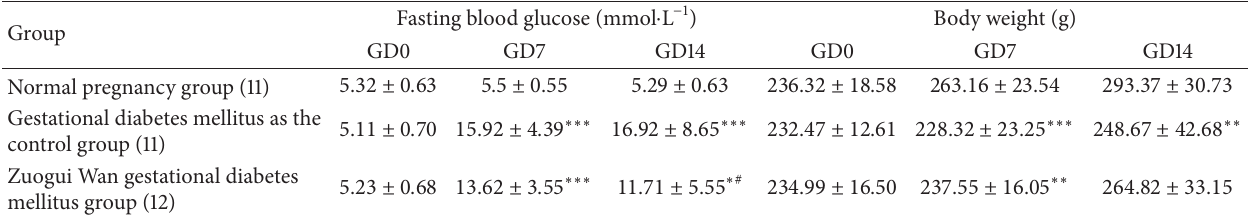
Table 1: Impact of Zuogui Wan on fasting blood glucose and body weight in rats of gestational diabetes mellitus.